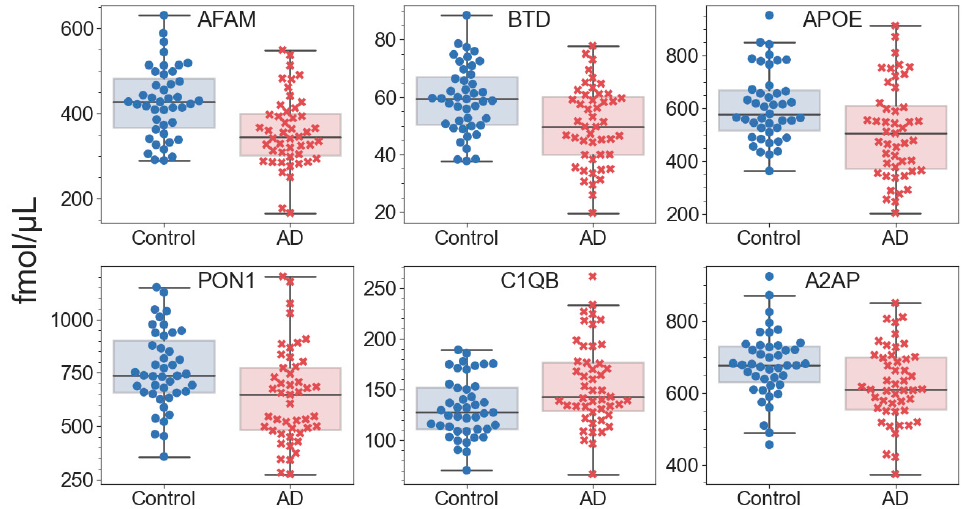
Figure 2. Differentiating proteins between the control and AD groups with uncorrected p -values ≤ 0.01 according to the Mann–Whitney U test. Lines inside boxes—medians; box flanges—25–75 percentiles; whisker range ± SD.